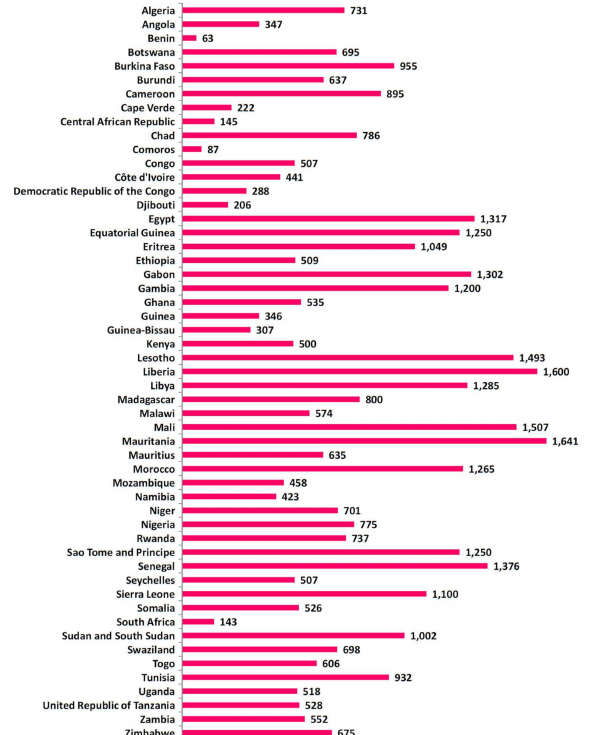
Figure 3. Irrigation water requirements (mm/year) in 2011 (in several cases the index values for the previous years are reported due to a lack of data) [12].